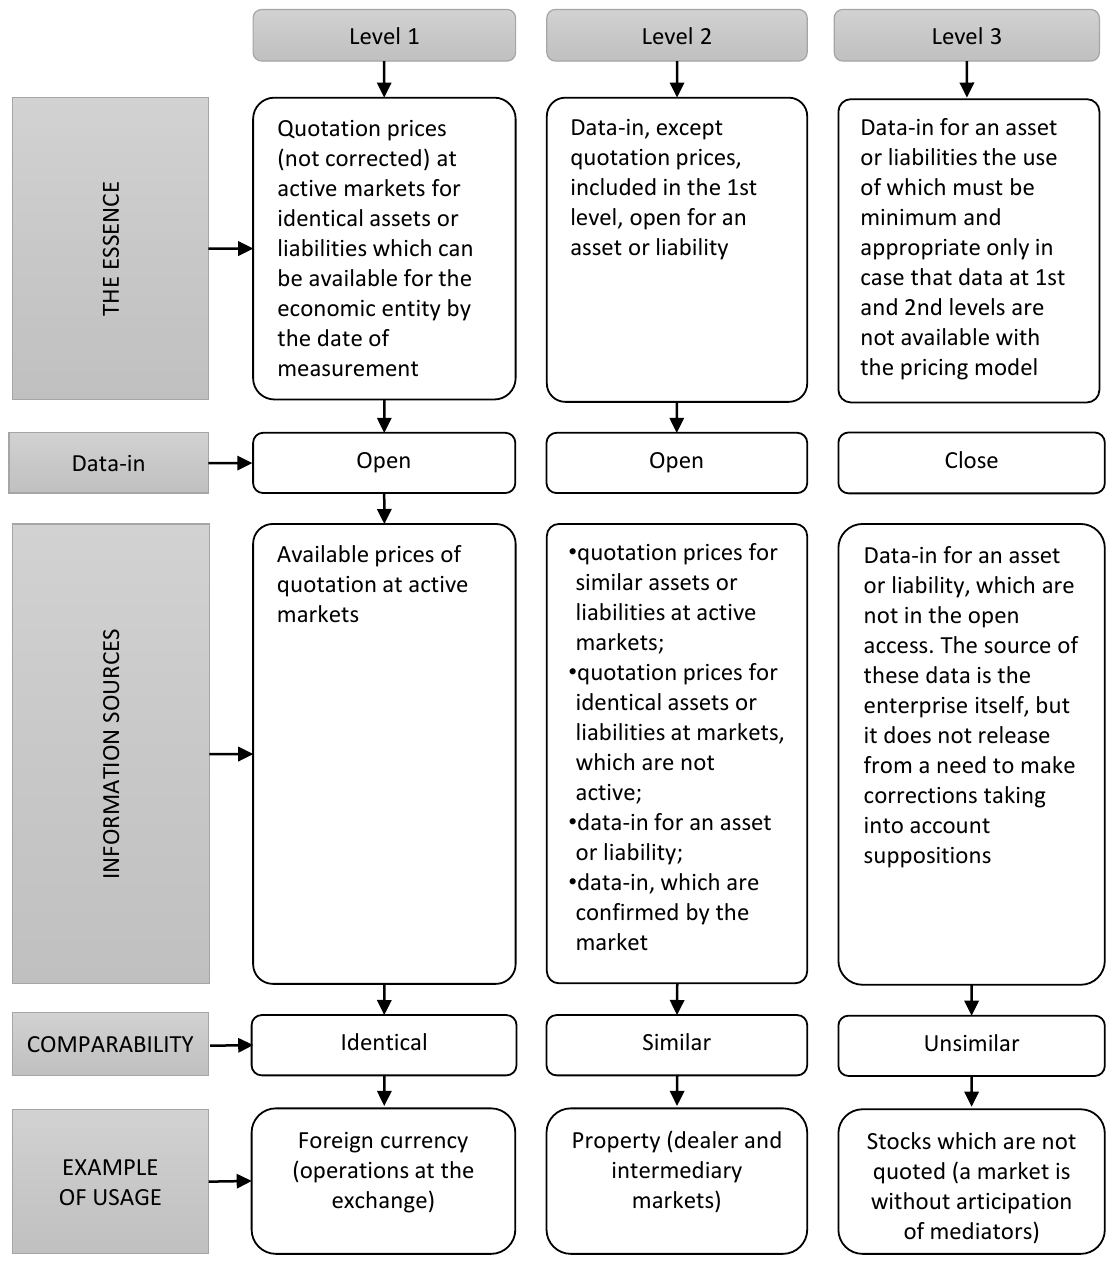
Figure 2. Comparison of levels of fair value